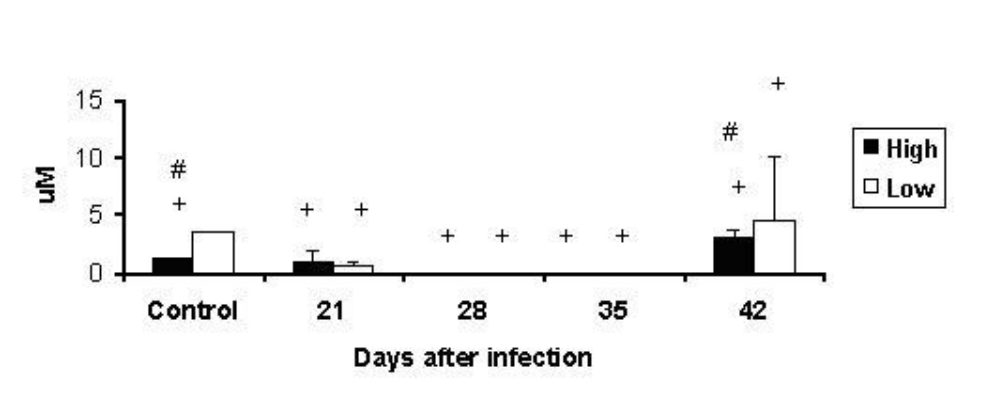
Figure 8. Production of NO ( μ M) in supernatants from culture of pulmonary macrophages of High and Low antibody producer (Selection IV-A) mice infected with Mycobacterium bovis- AN at different periods, compared with their respective 5 controls.